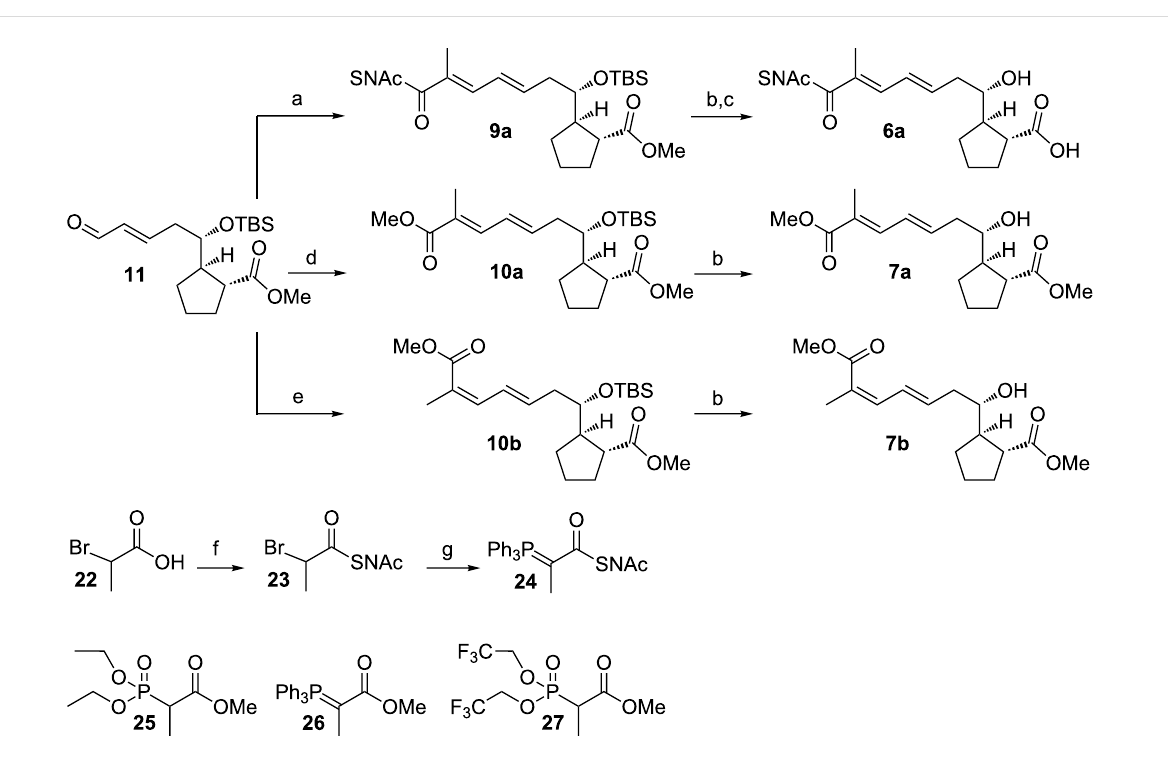
Scheme 4: Synthesis of reference compounds for the BorDH3 assay. a) 24 , CH 2 Cl 2 , 50 °C, 3 h (88% over two steps); b) THF/HCOOH/H 2 O (6:3:1), rt, 2 d (62% for 7a , 57% for 7b ); c) pig liver esterase, phosphate buffer, rt, 3 d (67% over two steps from 9a ); d) 25, NaH, THF, 0 °C, 3 h (18% over two steps from 12 ) or 26 , CH 2 Cl 2 , 50 °C, 21 h (64% over two steps from 12 ); e) 27 , 18-crown-6, K 2 CO 3 , THF, − 20 °C then 0 °C for 5 h (47% over two steps from 12 ); f) HSNAc, EDC, DMAP, CH 2 Cl 2 , rt, 16 h (78%); g) PPh 3 , H 2 O, 70 °C, 11 h, then NaOH, rt